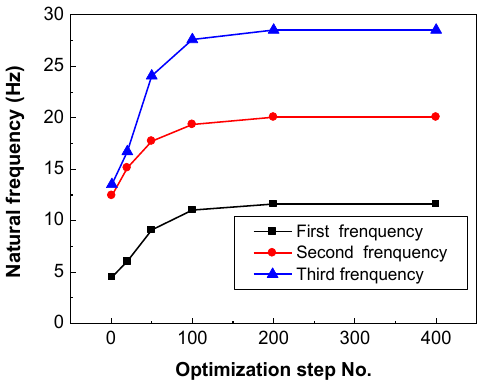
Figure 4. Shape variation of Model 1 during the optimization process: ( a ) Initial guess; ( b ) 20th step; and, ( c ) 200th/400th step (optimal).